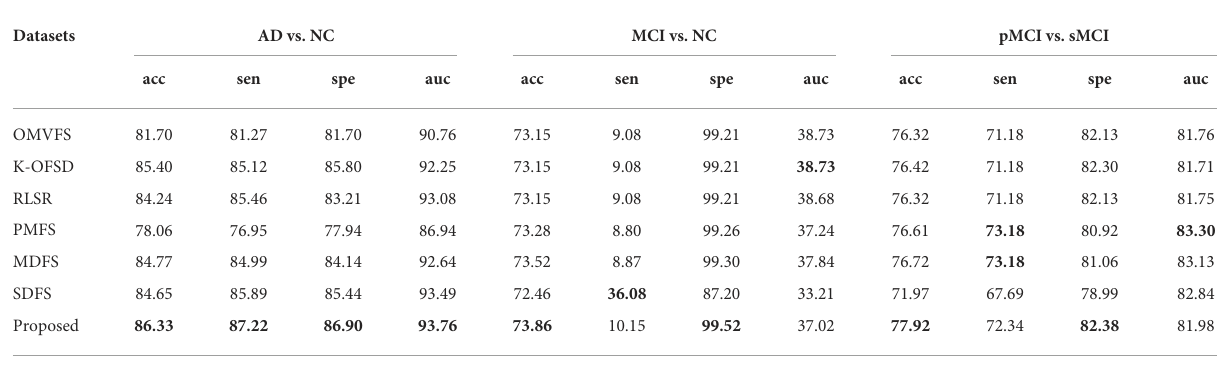
TABLE 2 Classification results of all algorithms on the three datasets (%). Datasets